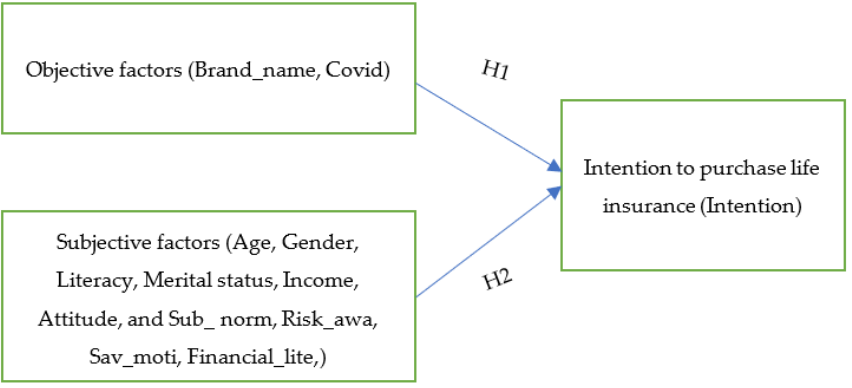
Figure 2. Research Model.